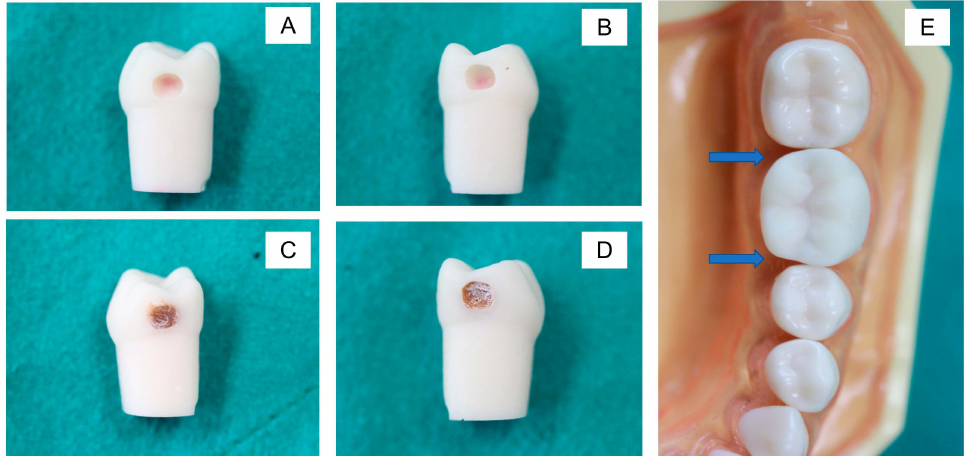
Figure 4. ( A , B ) Class II cavities in proximal surfaces. ( C , D ) We filled the cavities with RMGIC mixed with the color modifier. ( E ) We placed the tooth in a model. A slight dark shadow (arrows) can be observed underneath the marginal ridges, which could indicate the location of caries